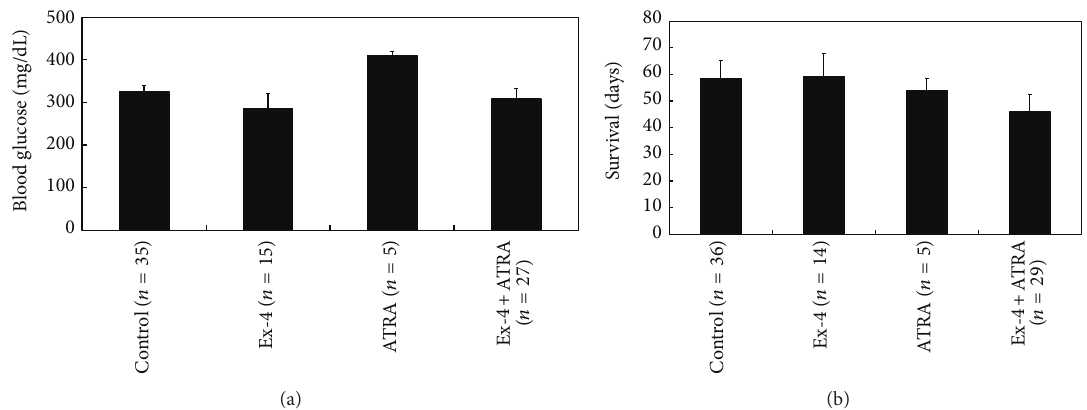
Figure 5: The lowest blood glucose levels (a) and survival time (b) in spontaneous diabetic NOD mice treated with and without ATRA and exendin-4 (Ex-4).